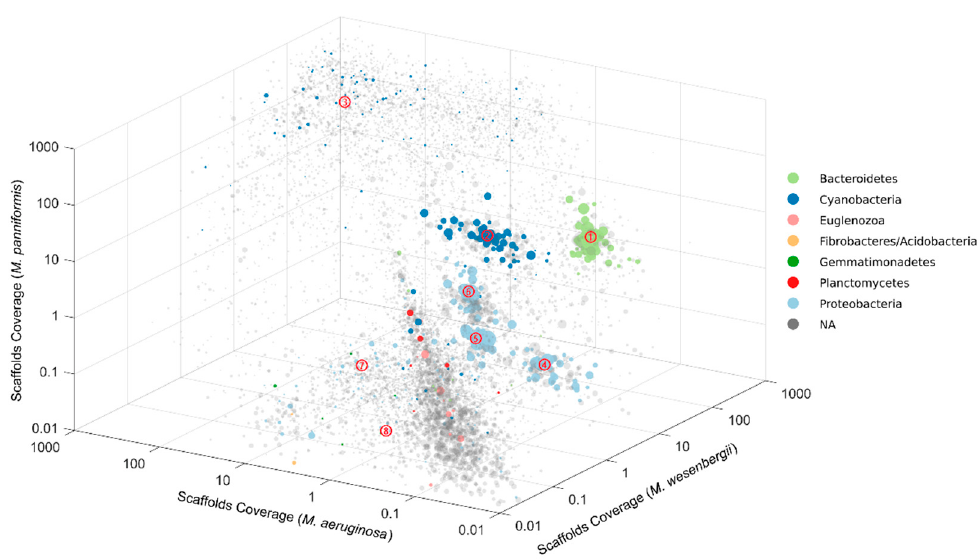
Figure 1. Sequence 3D coverage binning of metagenome scaffolds from the single Microcystis colonies. Plots represent scaffolds, the size indicates the length of scaffolds and the color shows the phylum-level taxonomic affiliation. Gray spots are scaffolds which cannot be assigned to the essential genes of the 8 most abundant phyla. Clusters of same colored spots represent potential genome bins, and are indicted by numbers in the center (Table 2). Spots in similar coverage pattern, such as around diagonal, were extracted and further binned based on the differences in nucleotide composition.